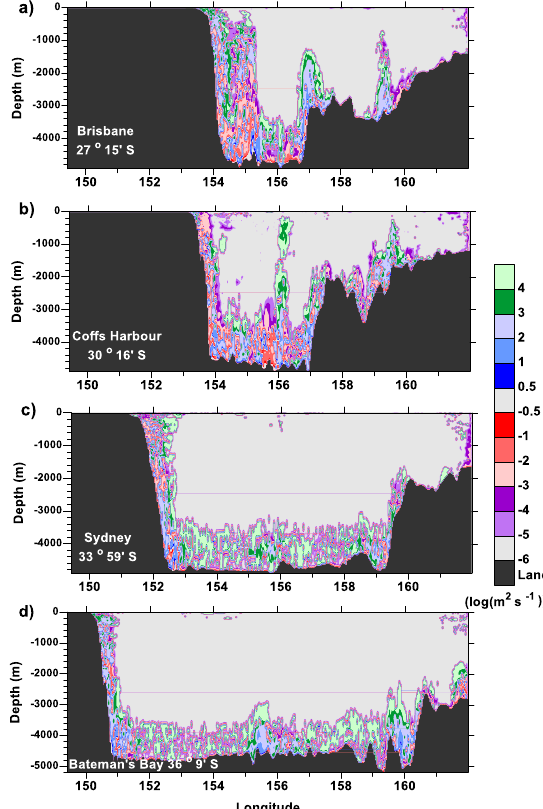
Fig. 13 Log of the significant vertical temperature diffusivity between the tidal and non-tidal simulations along four latitude transects: a 27° 15’ S off Brisbane, b 30° 16’ S off Coffs Harbour, c 33° 59’ S off Sydney, and a 36° 9’ S off Bateman’s Bay